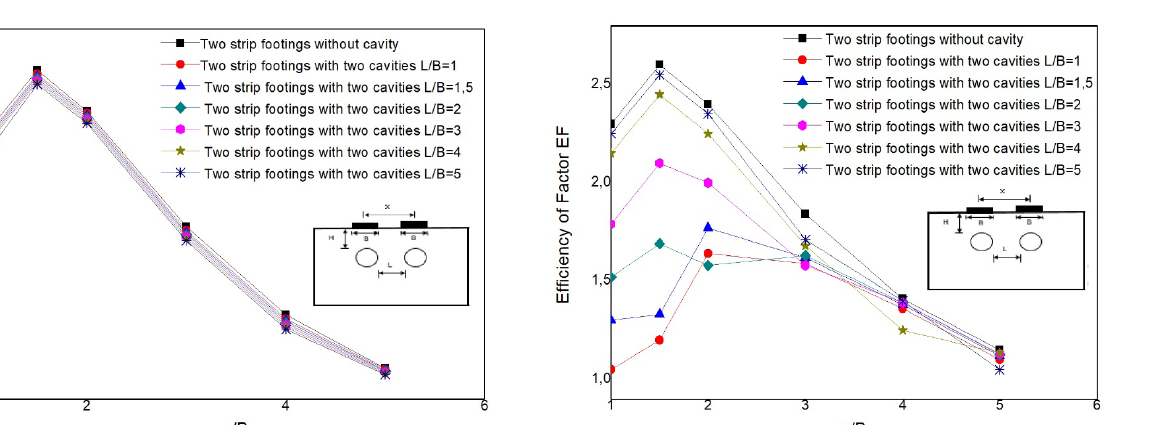
To compare the influence of the convergence of the cavities with footings on EF, the distance between the footings and the cavities was reduced to H/B = 2, the variation of the EF as a function of x/B are illustrated in Figure 11. The obtained results revealed that the presence of cavities below the footings minimized the EF and the interference effect between the footings. Also, the convergence between the footings and cavities (H/B = 3 to H/B = 2) decrease the performance of interference effect.